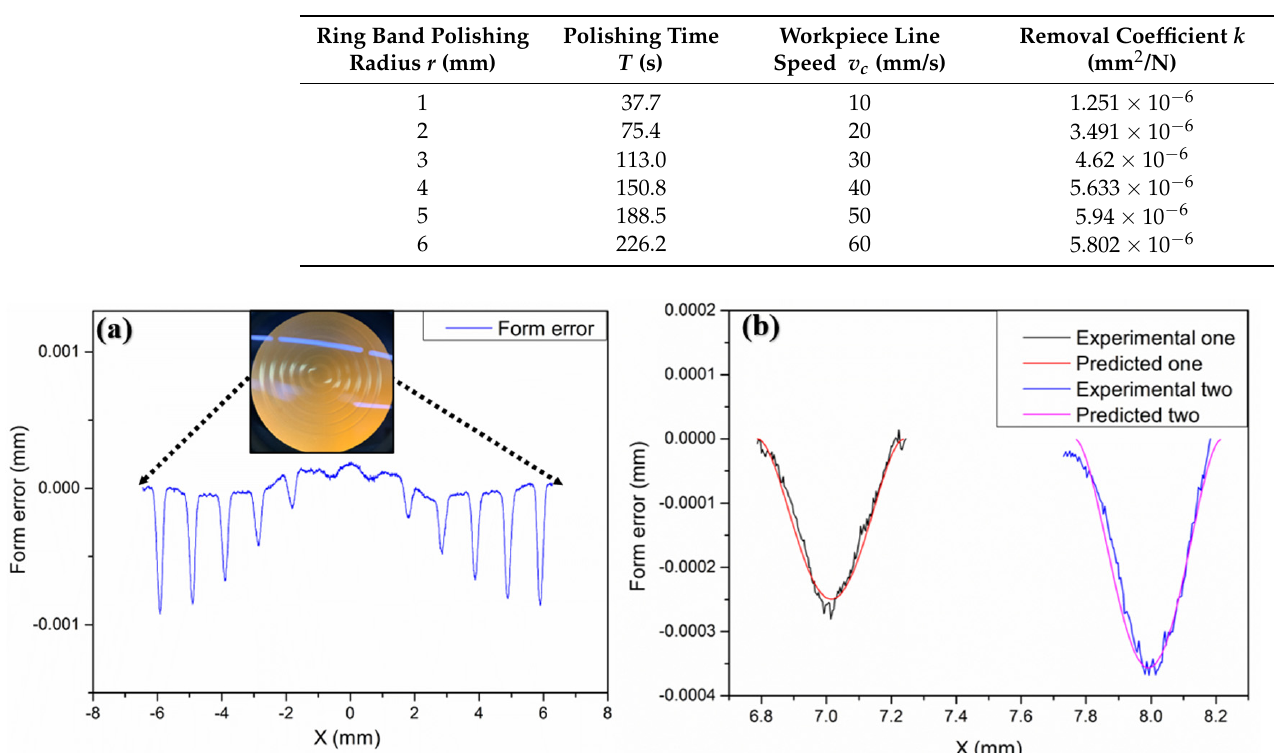
Table 2. Parameters and results of the ring band experiment.